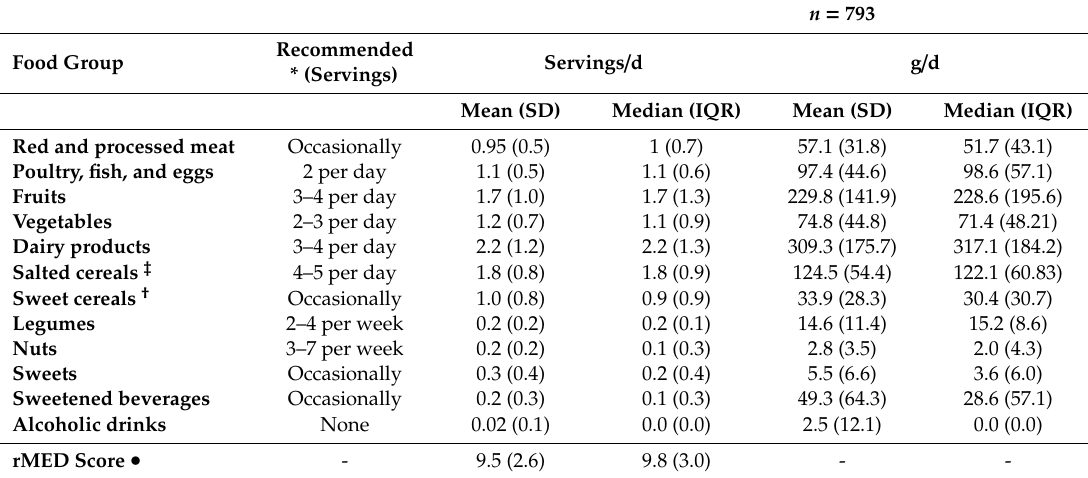
Table 2. Food consumption in pregnant women in the first trimester of